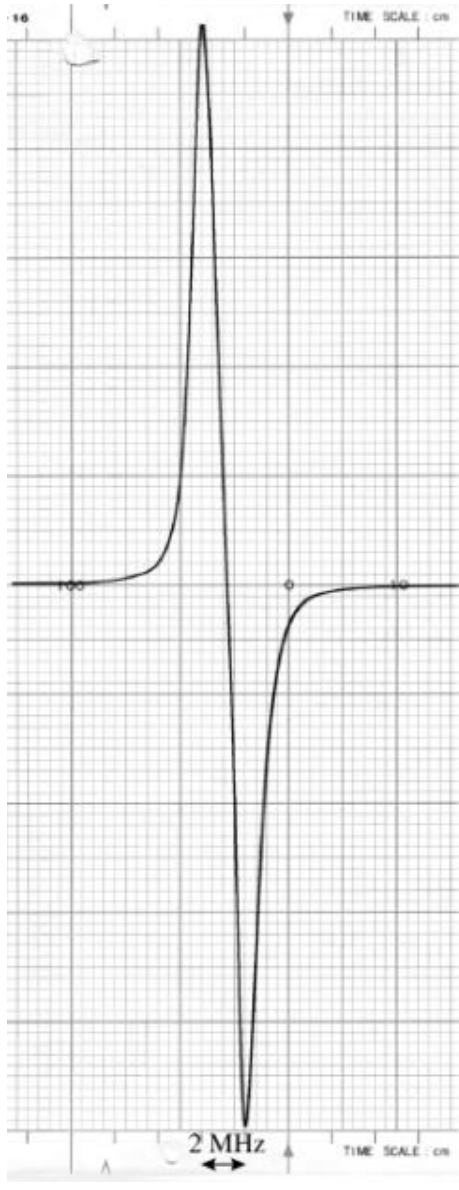
‹ 16 = 1 , E, 16 , of co 2 1 , u = 1 ‹ 15 , u = 0. The 1 co 1 co